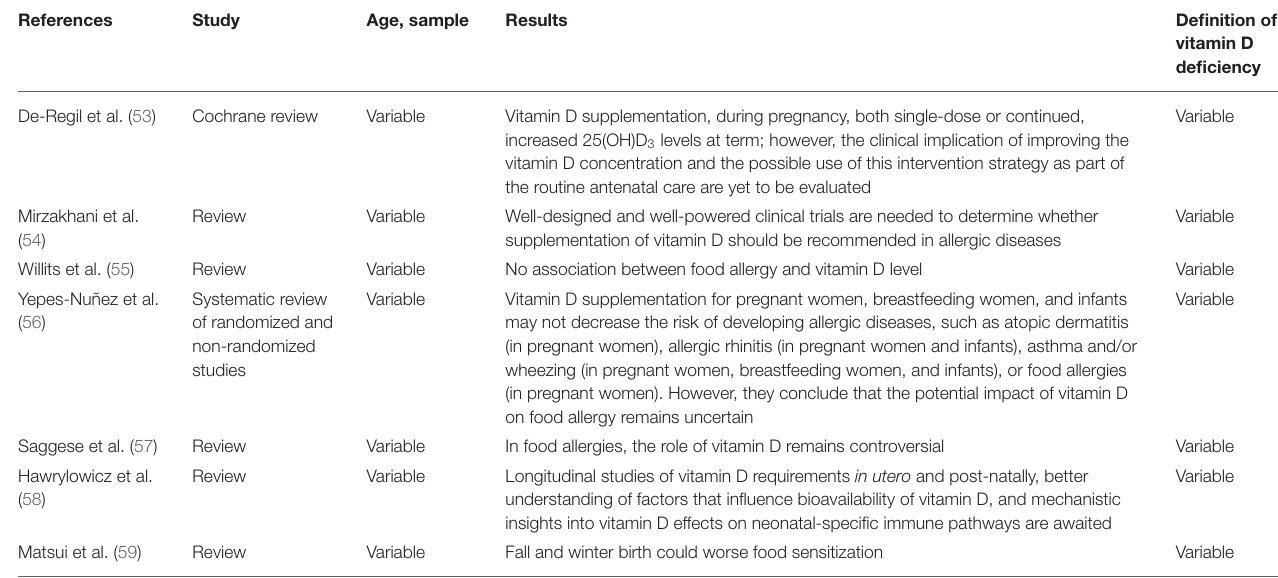
TABLE 2 | Summary of review on the possible role of vitamin D in the development of food